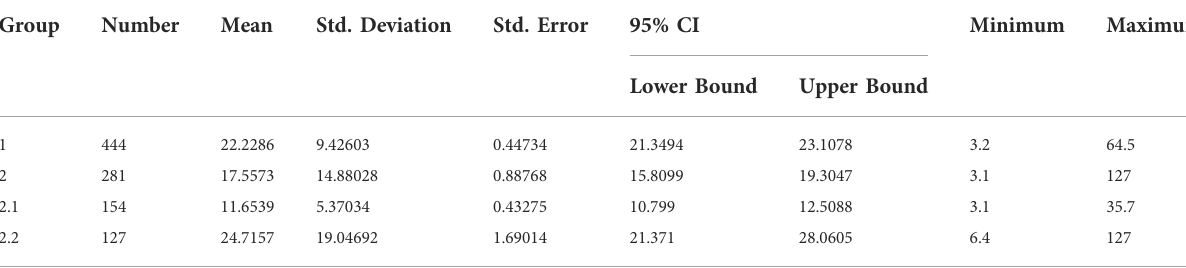
TABLE 3 SUVmax for each group of bone lesions.